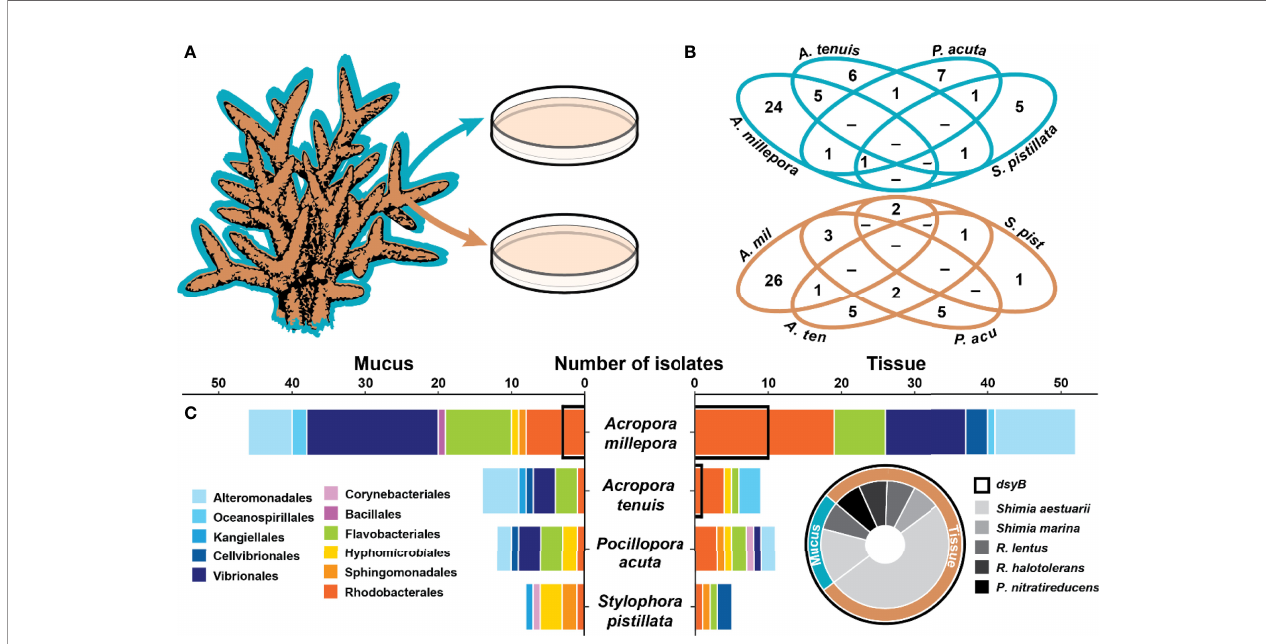
FIGURE 1 | Coral associated bacteria harbour the dsyB gene. (A) Isolation of 157 bacteria from the mucus (blue) and tissue (brown) of four coral species. (B) Venn diagrams for the mucus (blue) and tissue (brown) of the four species showing the overlap in the isolated bacterial species (identi fi ed by their 16S rRNA gene) between the four coral species. (C) Taxonomic composition of the isolates (order level) between the four coral species for the mucus (left panel) and the tissue (right panel). Isolates harbouring dsyB (14 of 157) are indicated by a black outline on the bar graph and their taxonomic composition is presented as a pie chart (for more information, see Table S2 ). The genera Roseivivax and Pseudooceanicola are